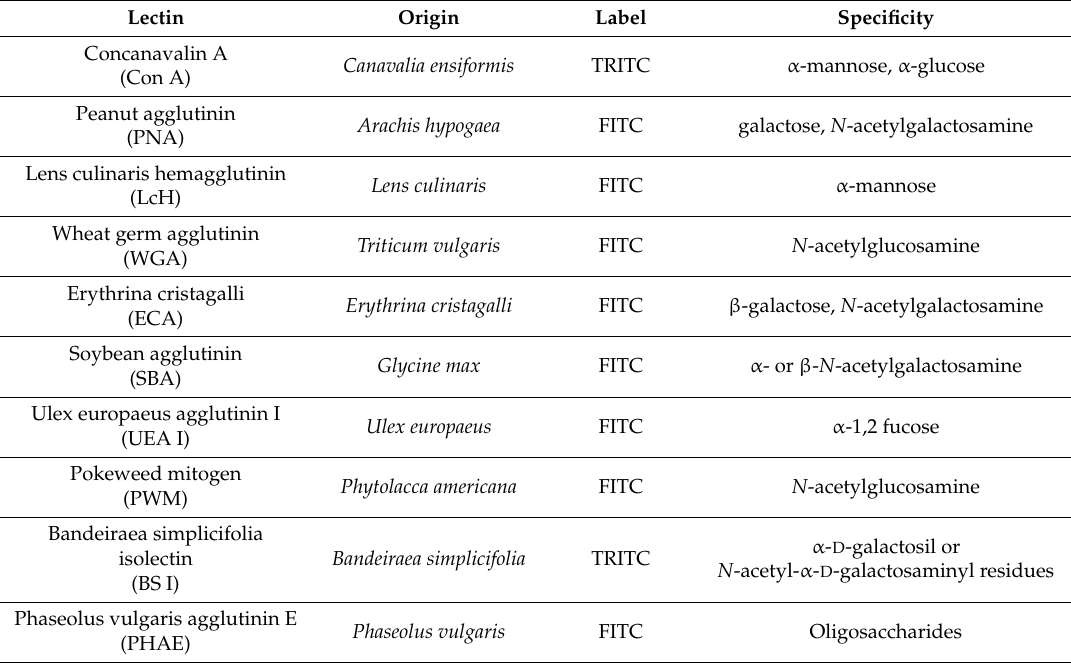
Table 1. Characteristics of lectins employed in this